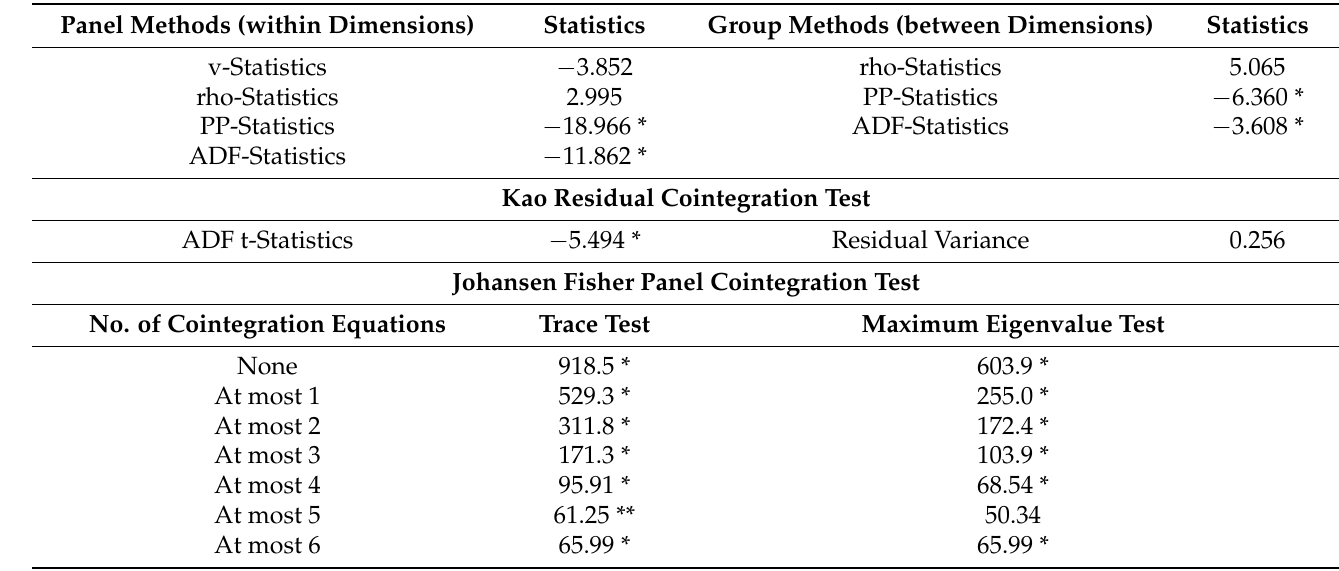
Table 6. Estimates of Pedroni Residual Cointegration Test.